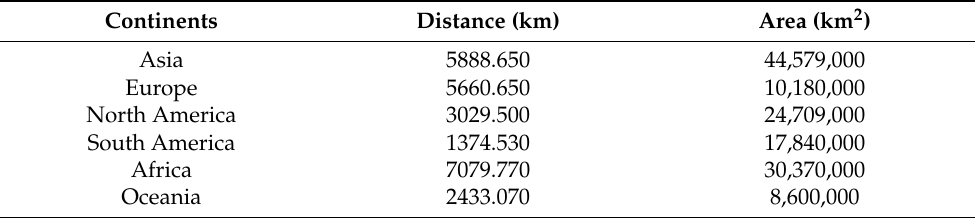
Table 2. Geographic centroid migration distance for the COVID-19 pandemic on six continents. Continents Distance (km) Area (km 2 ) Asia 5888.650